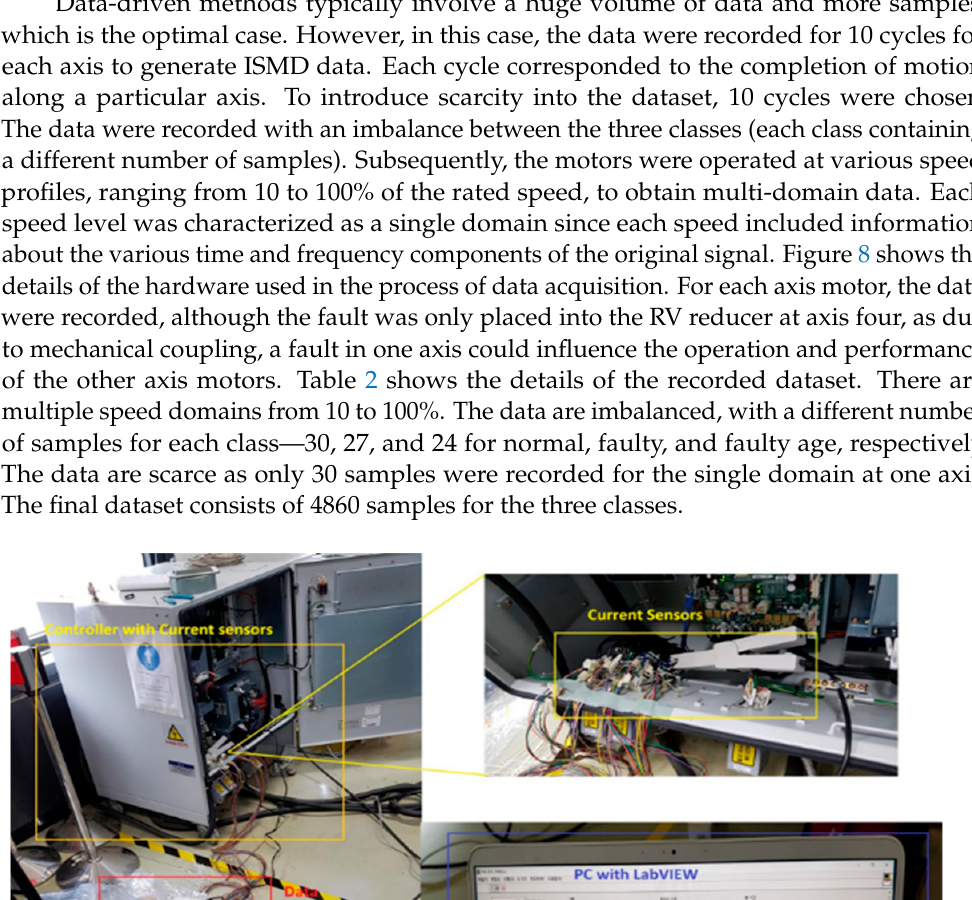
Figure 7. Example of a faulty specimen and fault types.